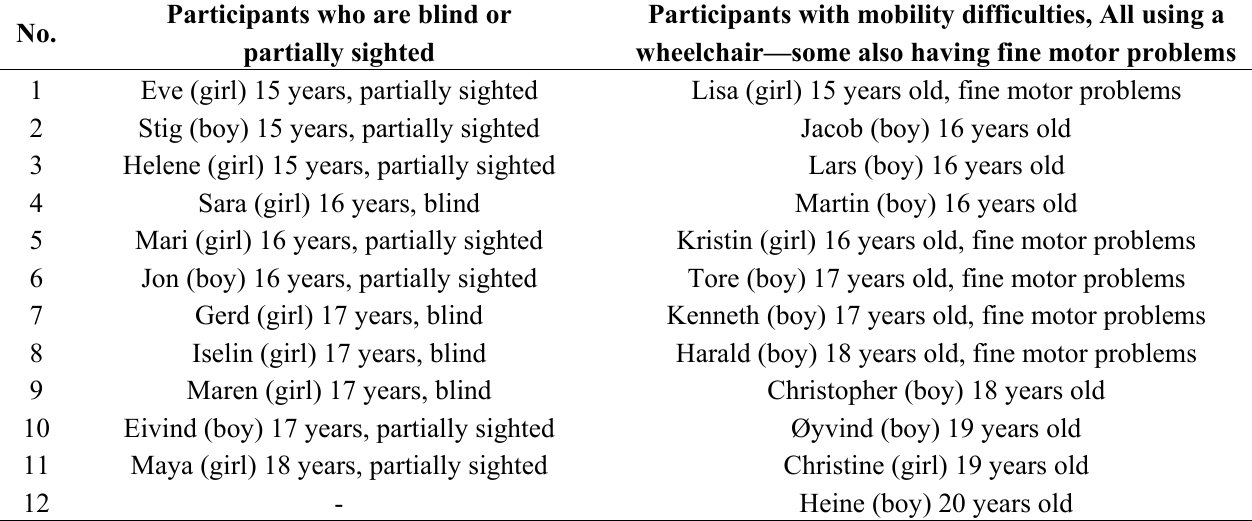
Table 1. Participants in the